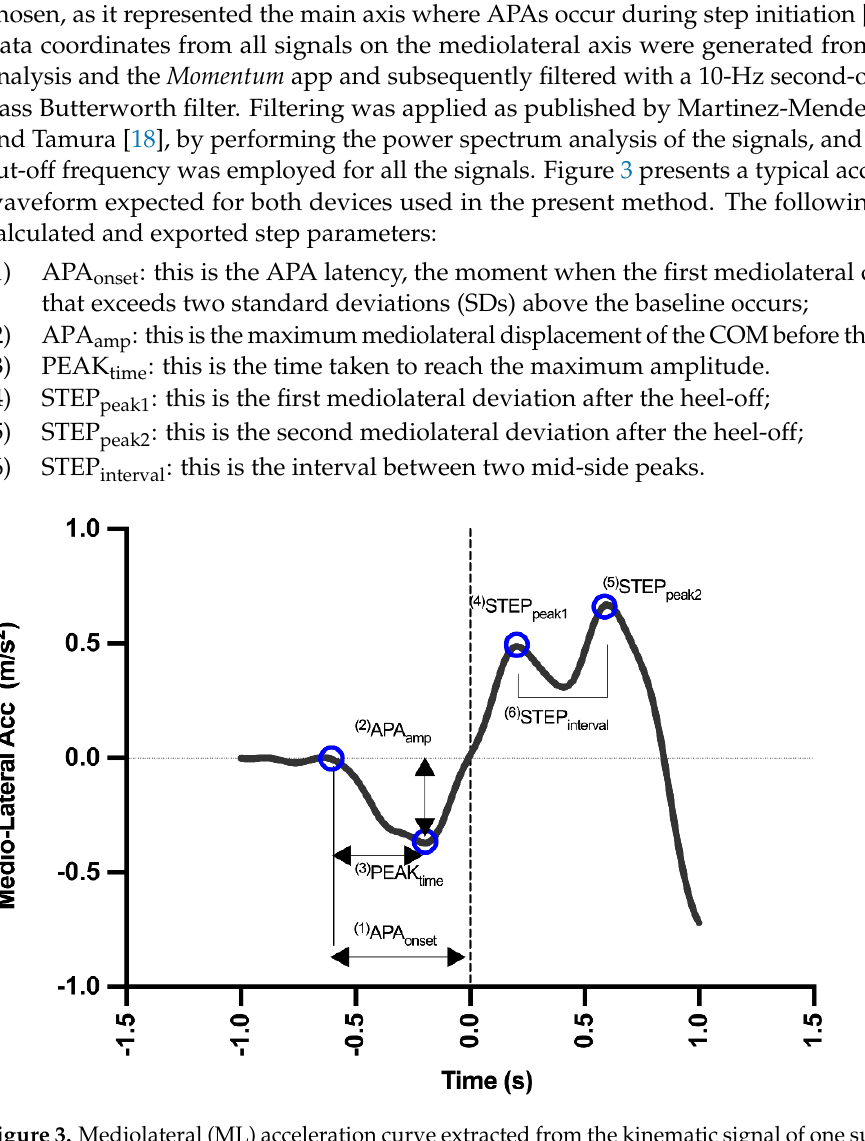
Figure 3. Mediolateral (ML) acceleration curve extracted from the kinematic signal of one subject. The variables included in the method are expressed by numbers and blue circles in the graph (meaning of each variable are explained in method session). The dashed line represents moment when heel leaves